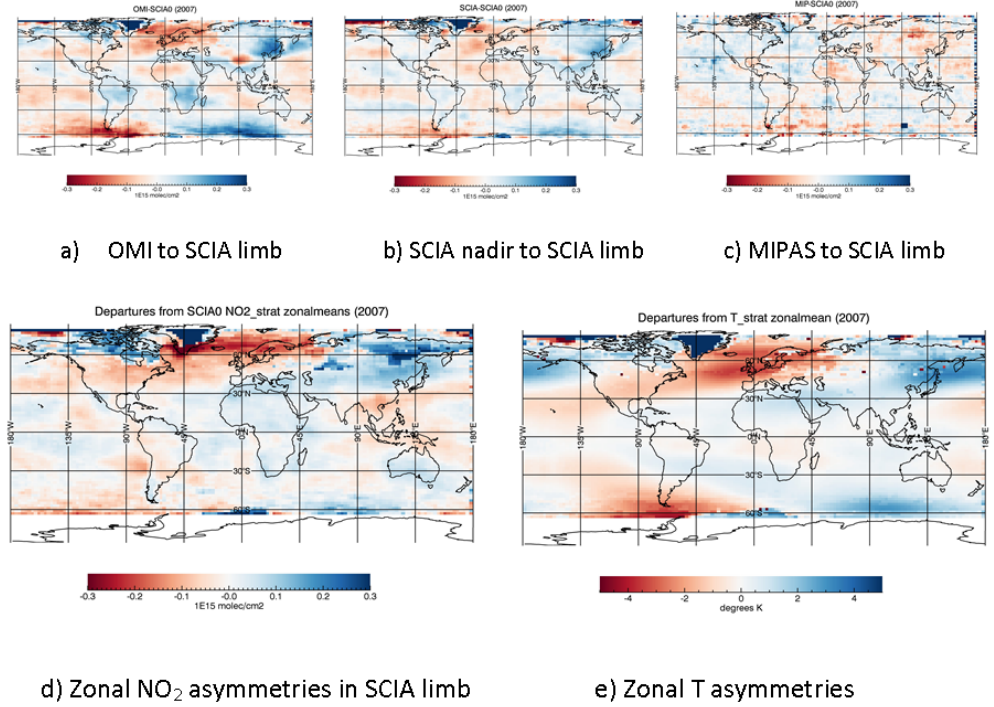
Figure 14. Same as Fig. 13 but for 2007. MIPAS sampling is denser in 2007, so the differences between MIPAS and SCIAMACHY limb come out